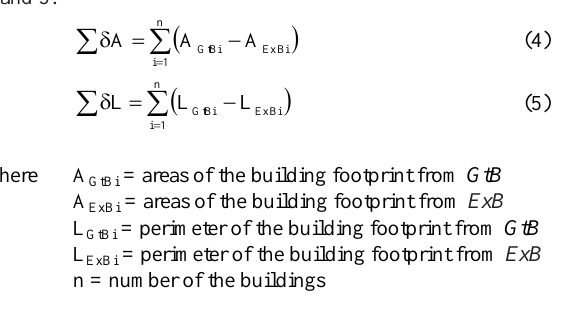
Figure 5. Illustration of determining a pair of L GtBi and L ExBj